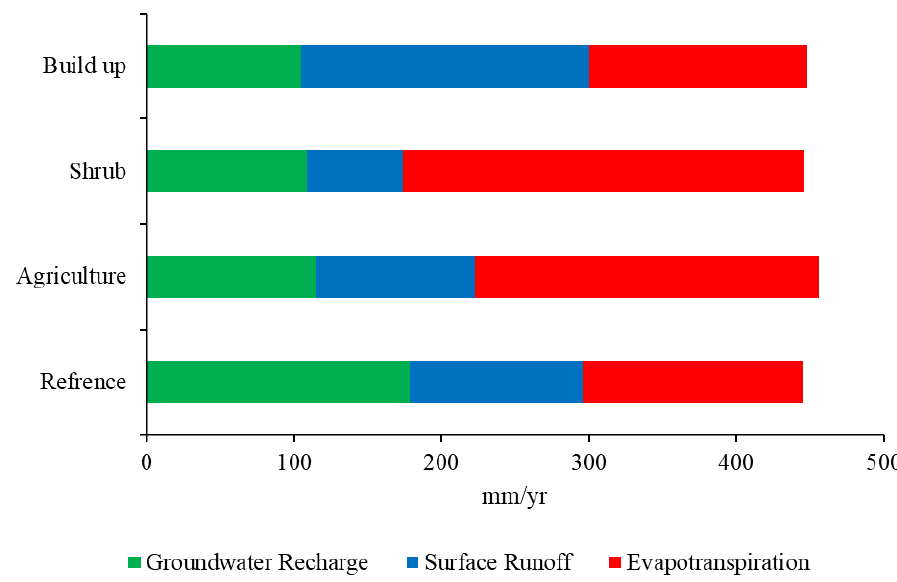
Figure 12. Variation of average annual water balance components for different land-use types.